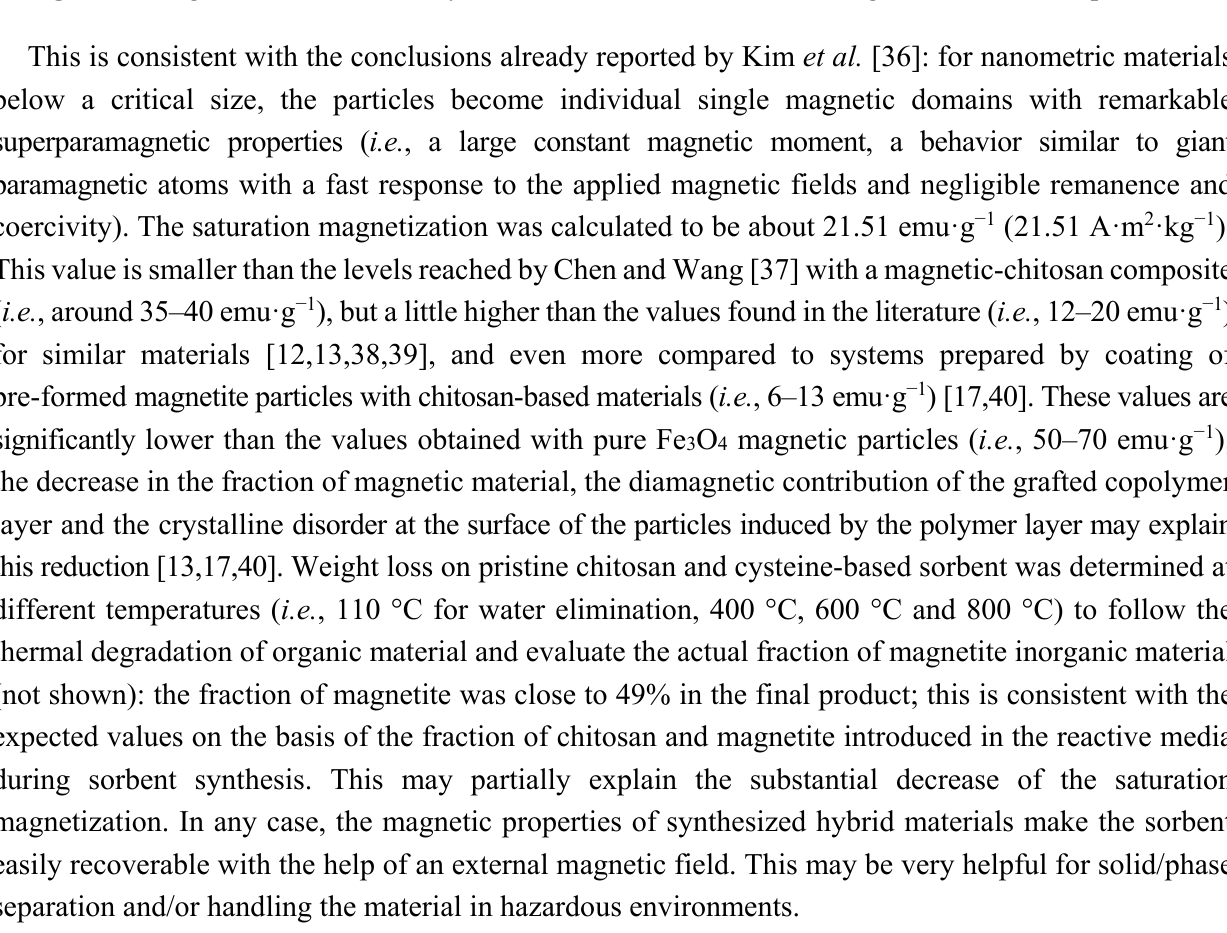
Figure 5. Magnetization curve of cysteine-functionalized chitosan magnetic nano-based